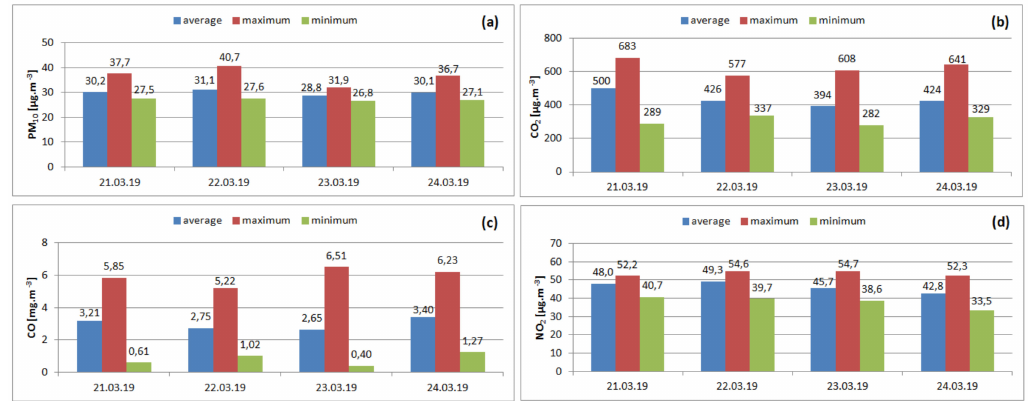
Figure 7. Minimum, maximum and average values of daily gas concentrations and PM, ( a ) PM 10 , ( b ) CO 2 , ( c ) CO, ( d ) NO 2